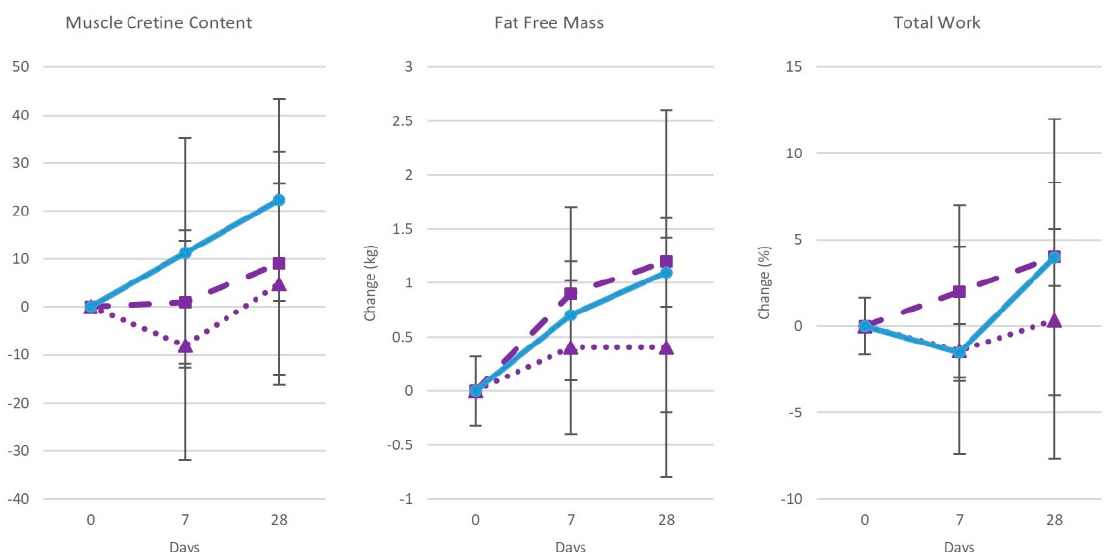
Figure 13. Changes in muscle creatine content, fat-free mass, and 30 s cycling sprint performance after 7 and 28 days of CrM-Alk supplementation at 1.5 g/day recommended doses ( ▲ ), CrM-Alk supplementation of 20 g/day for 7 days and 5 g/day for 21 days ( ◼ ), or CrM supplementation of 20 g/day for 7 days and 5 g/day for 21 days ( ● ). Adapted from Jagim et al. [28].